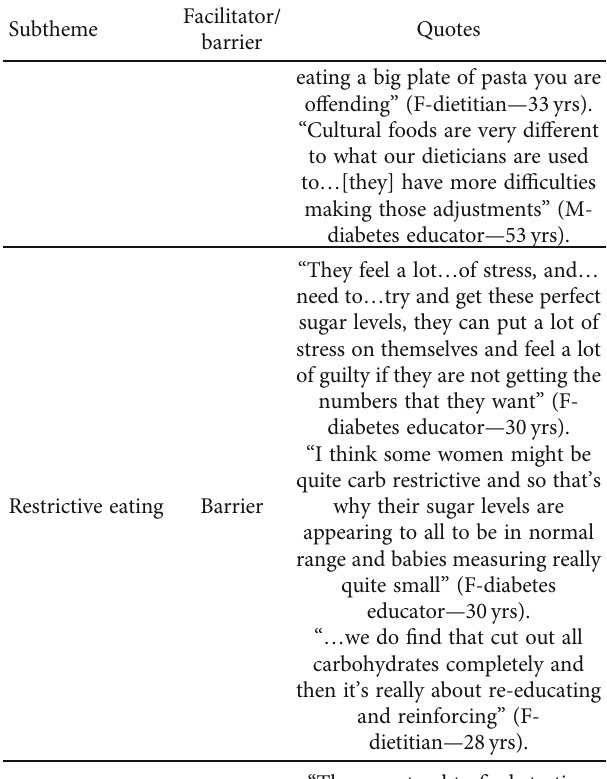
Table 2: Barriers and facilitators to current management practices of diabetes educators and